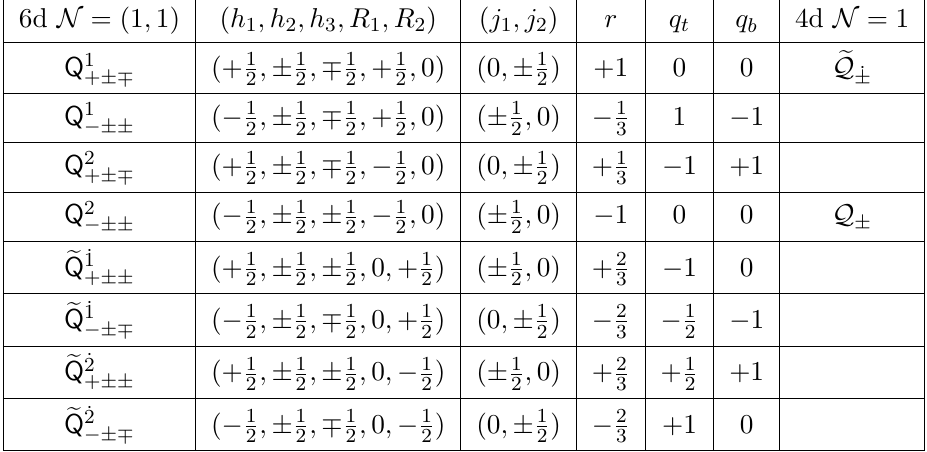
Table 6. One choice of embedding of the 4d N = 1 superalgebra into the 6d N = (1 , 1) super-